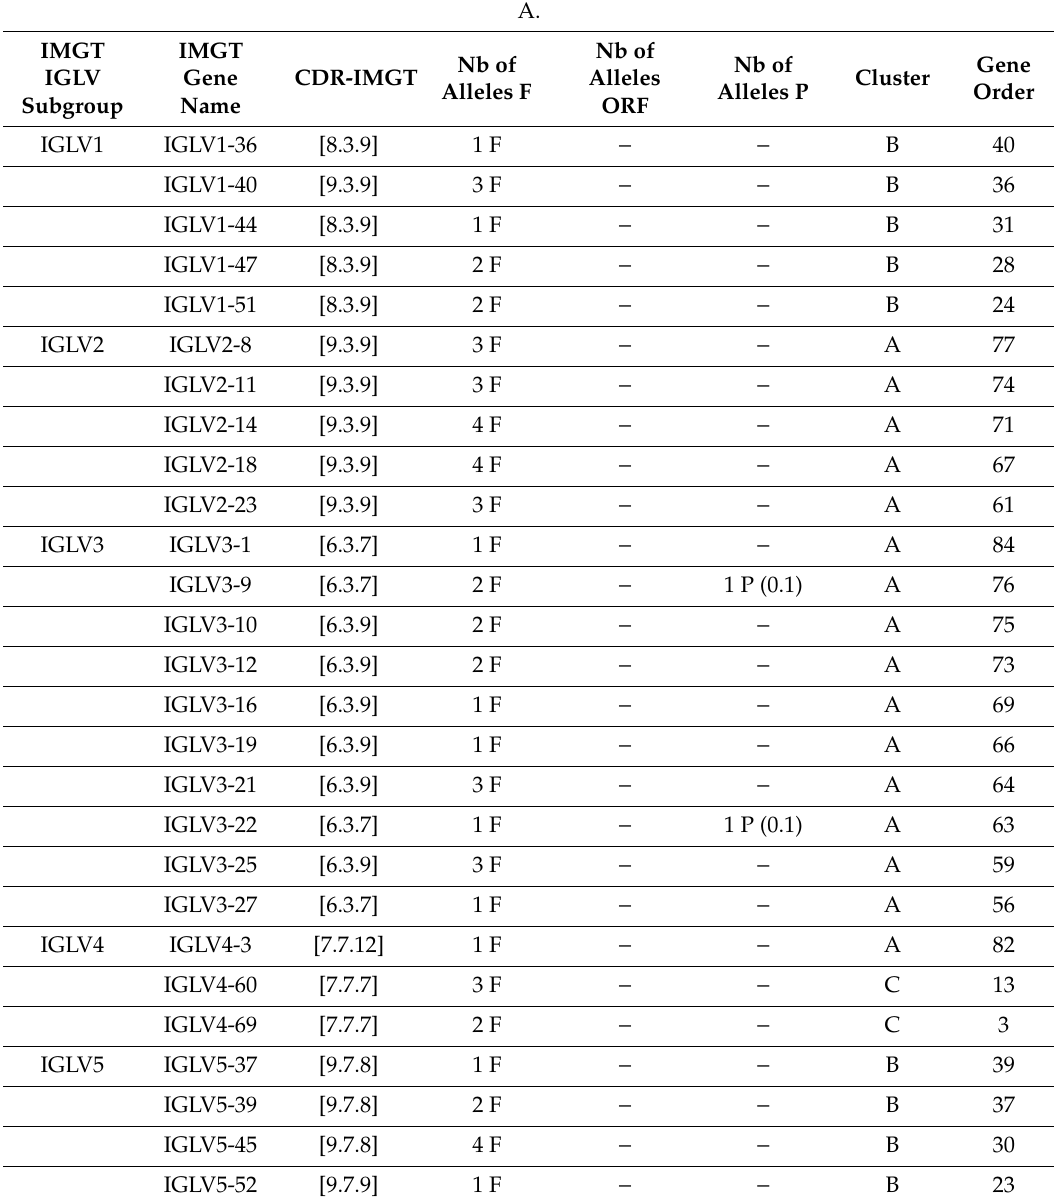
Table 9. Potential Homo sapiens IGL genomic repertoire. A. Homo sapiens IGL V-CLUSTER. B. Homo sapiens IGL J-C-CLUSTER.